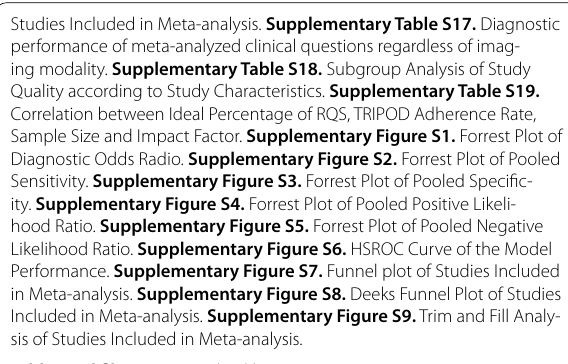
Studies Included in Meta-analysis. Supplementary Table S17. Diagnostic performance of meta-analyzed clinical questions regardless of imag- ing modality. Supplementary Table S18. Subgroup Analysis of Study Quality according to Study Characteristics. Supplementary Table S19. Correlation between Ideal Percentage of RQS, TRIPOD Adherence Rate, Sample Size and Impact Factor. Supplementary Figure S1. Forrest Plot of Diagnostic Odds Radio. Supplementary Figure S2. Forrest Plot of Pooled Sensitivity. Supplementary Figure S3. Forrest Plot of Pooled Specific- ity. Supplementary Figure S4. Forrest Plot of Pooled Positive Likeli- hood Ratio. Supplementary Figure S5. Forrest Plot of Pooled Negative Likelihood Ratio. Supplementary Figure S6. HSROC Curve of the Model Performance. Supplementary Figure S7. Funnel plot of Studies Included in Meta-analysis. Supplementary Figure S8. Deeks Funnel Plot of Studies Included in Meta-analysis. Supplementary Figure S9. Trim and Fill Analy- sis of Studies Included in